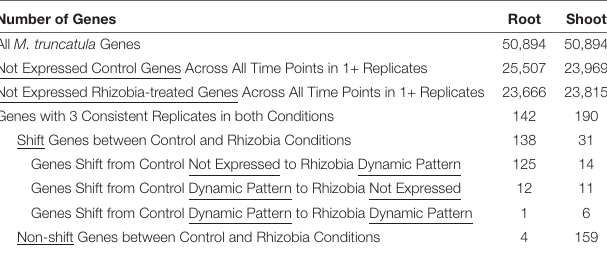
TABLE 1 | Medicago truncatula GeneShift results summary for 3/3